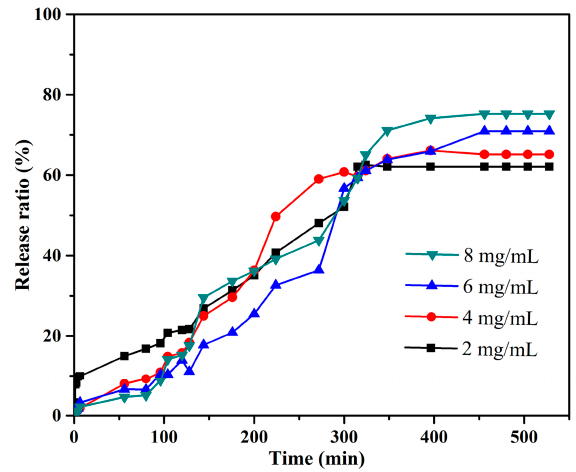
Figure 11. Release capacities of TC16-Fl organogels in n-pentanol with different CR concentrations.